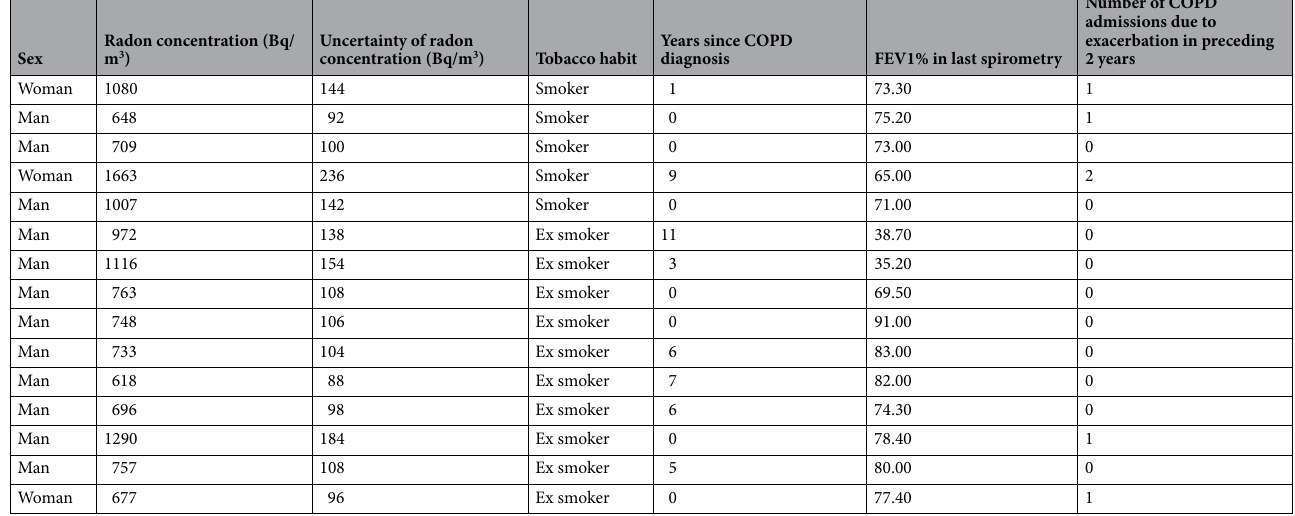
Table 3. Description of COPD cases with measurement of residential radon > 600 Bq/m 3